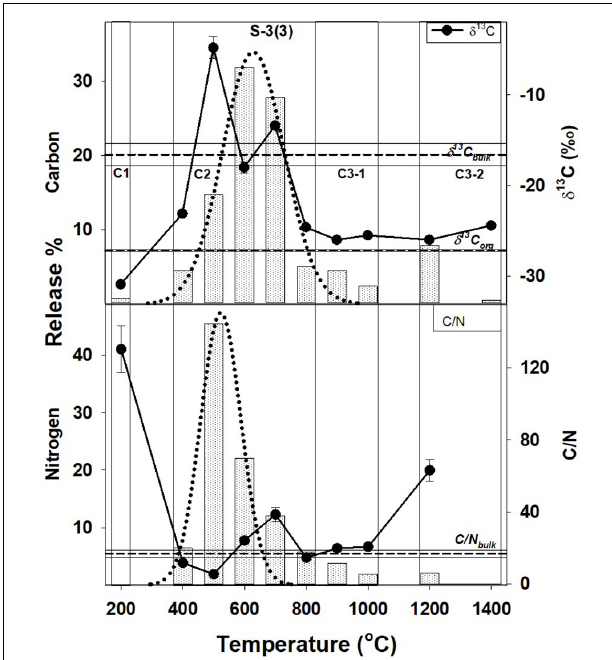
FIGURE 3 | Step combustion temperature vs. carbon and nitrogen release percent for S-3(3). The isotopic and elemental ratios for each temperature step are shown along with the bulk values and the corresponding OC components [C-1, C-2, C-3(a), and C-3(b)]. For further details, refer to text and Figure 1